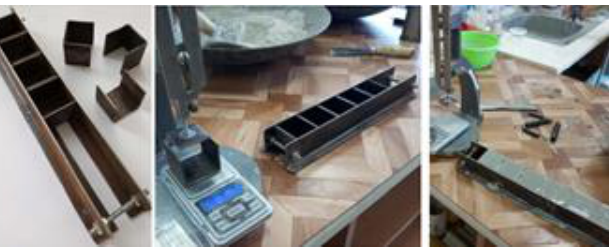
Figure 4. A set of equipment and devices for determining the bearing capacity of a newly formed